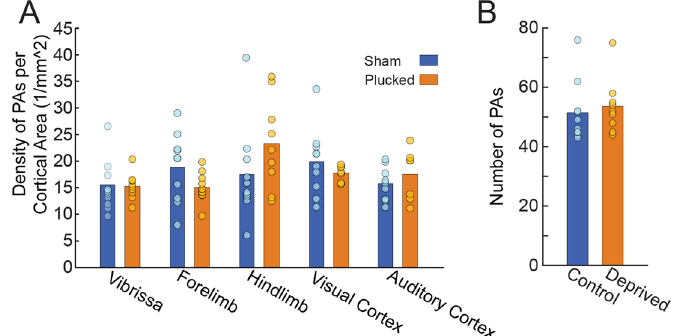
Figure 2. ( A ) Density of PAs plotted for five identified cortical areas (Sham: n = 10; Plucked: n = 9). Bars show mean across animals within a treatment (sham or deprived); circles show data points from individual animals. Color denotes group. ( B ) Comparison of the total number of PAs in plucked and control mice within the anatomically-identified barrel, forelimb and hindlimb areas. The PA count spans a factor of two in both